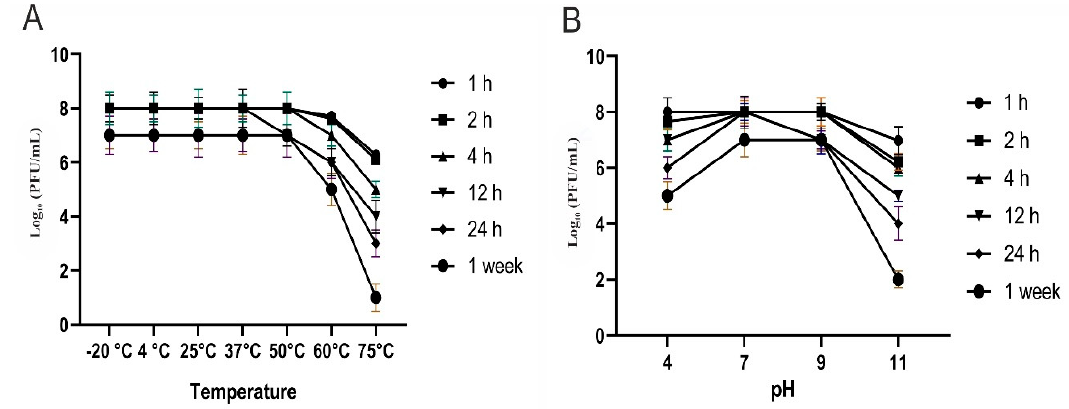
Figure 5. Titers stability of CoNShP-3 phage at different time periods (2 h, 4 h, 12 h, 24 h, and 1 week). ( A ) under different temperatures. ( B ) under different pH values.